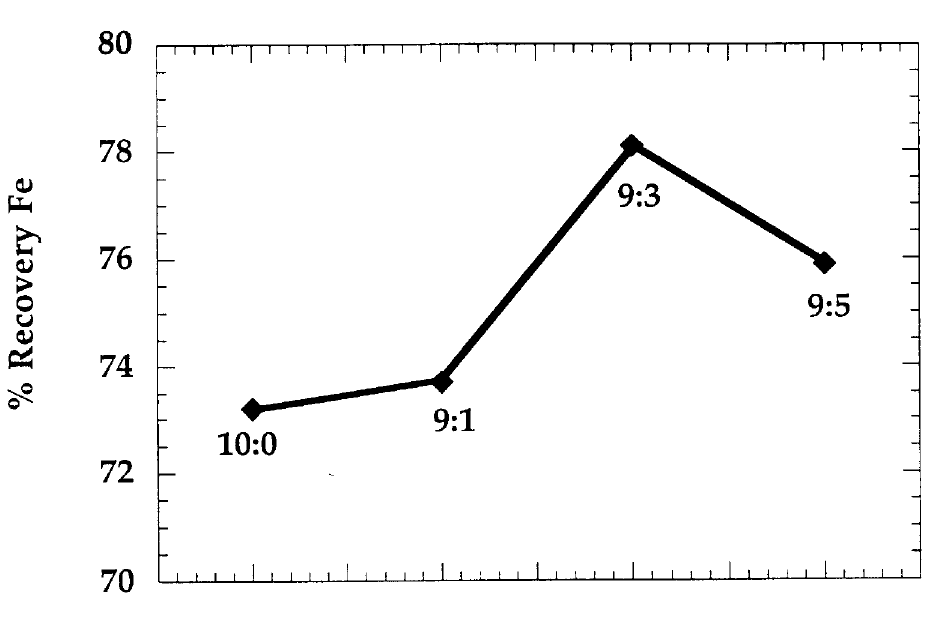
PERCENT RECOVERY OF IRON FROM NIST SRM 2704 (BUFFALO RIVER SEDIMENT) VERSUS VARIOUS COMBINATIONS OF NITRIC AND HYDROCHLORIC ACIDS (N=6)